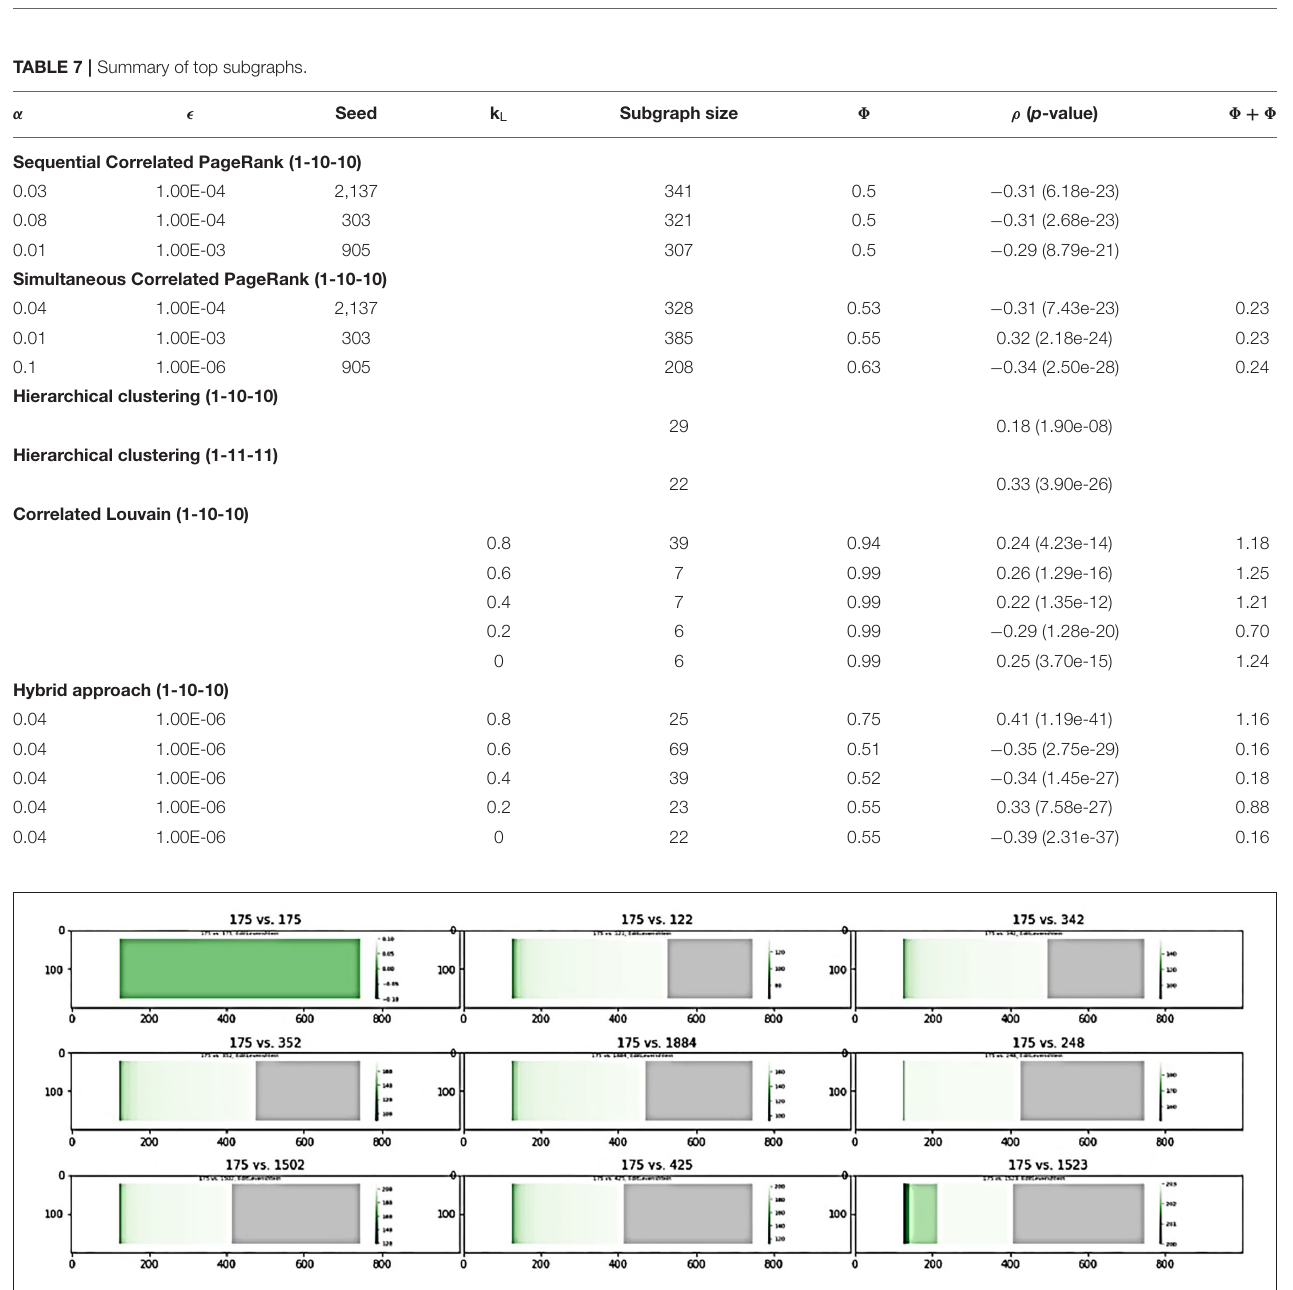
FIGURE 7 | Visual comparison of subnet 175 with other top